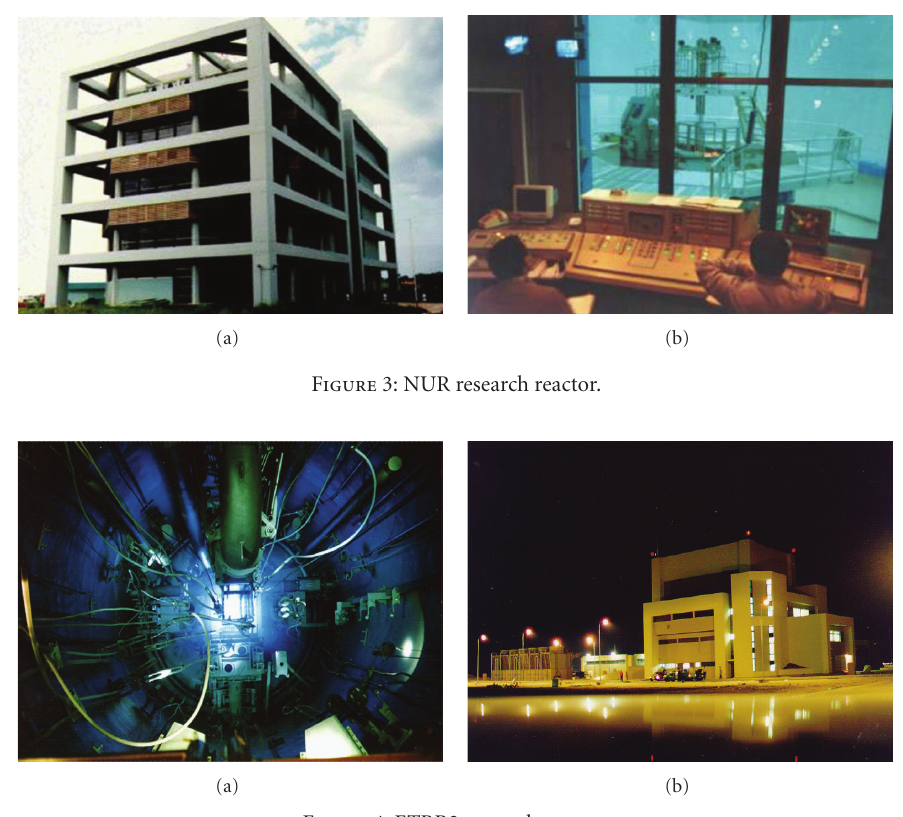
Figure 4: ETRR2 research